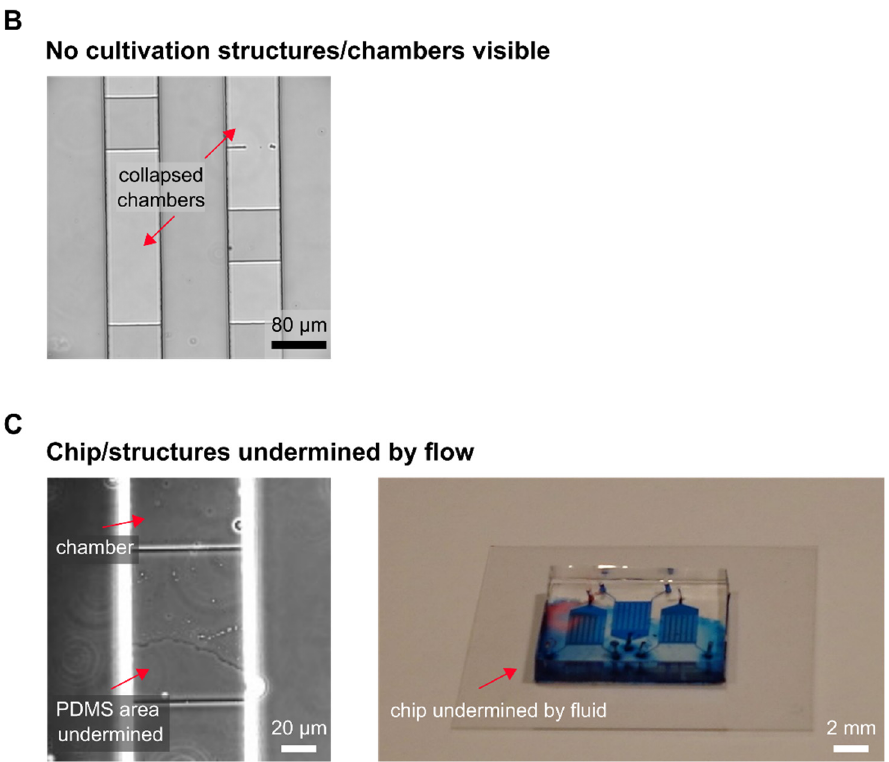
Figure A1. Example images of the fabrication errors (see Table 1). Microscope images of ( A ) Particles and hairs on the chip structures. ( B ) No cultivation structures/chambers visible. ( C ) Chip/structures undermined by fluid.